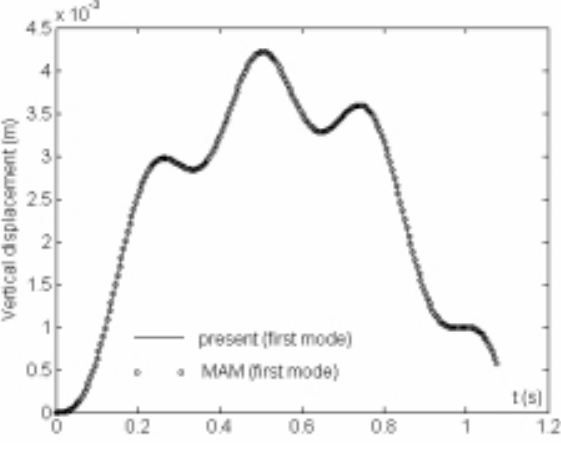
Fig. 5. The time history of vertical displacement of midpoint of beam.